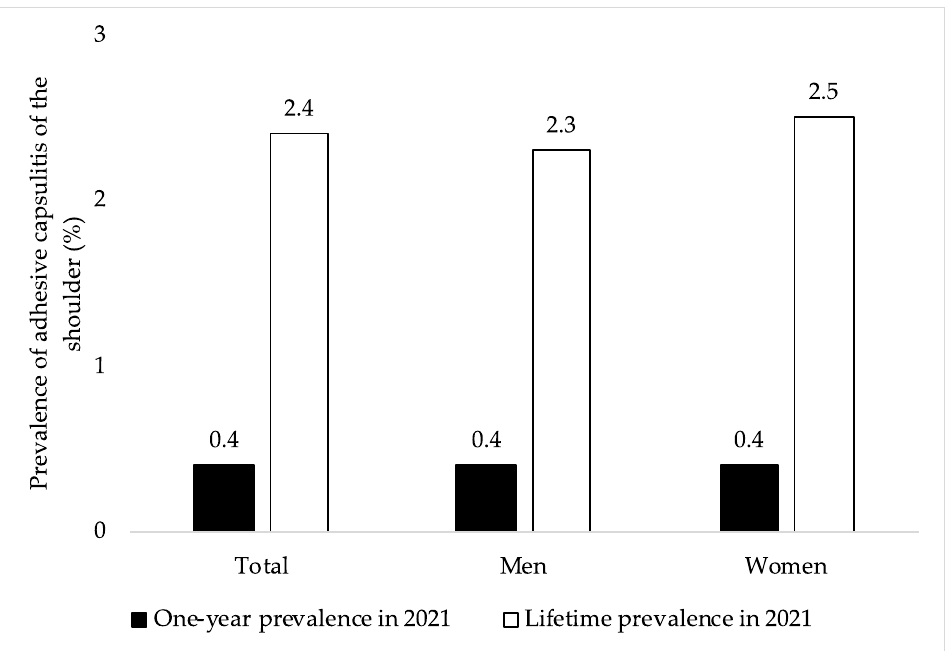
Figure 2. One-year and lifetime prevalence of adhesive capsulitis of the shoulder in 2021 in this sample of adults aged ≥ 65 years from Germany (overall and by sex). Abbreviation: ICD-10, International Classification of Diseases, 10th revision. One-year prevalence of adhesive capsulitis of the shoulder was defined as the proportion of individuals diagnosed at least once with adhesive capsulitis (ICD-10 code: M75.0) in 2021 among patients with at least one visit to their general practice in 2021. Lifetime prevalence of adhesive capsulitis of the shoulder was defined as the proportion of individuals diagnosed at least once with adhesive capsulitis in their whole medical history among patients with at least one visit to their general practice in 2021.